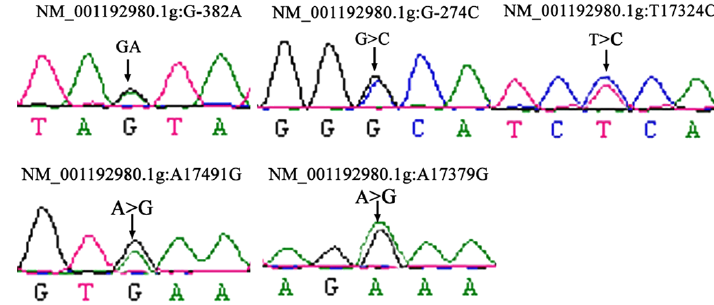
Figure 1. Schematic representation of the SIRT1 gene with the localization of the five identified SNPs.